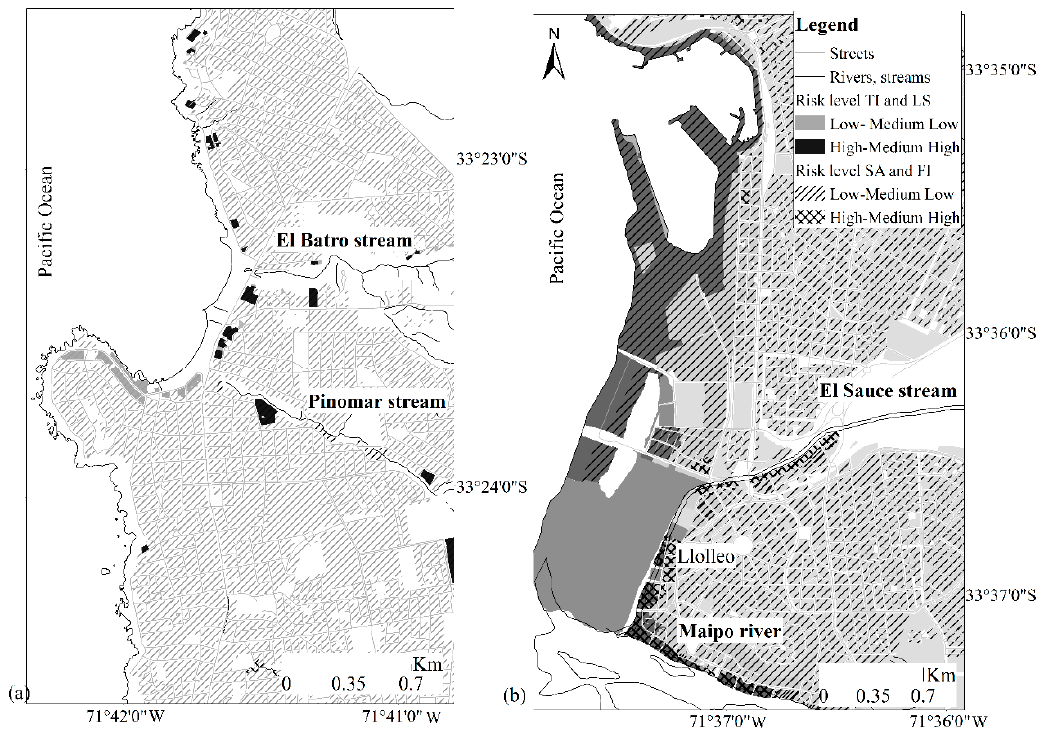
Figure 8. Housing integrated level of risk in ( a ) El Quisco and ( b ) San Antonio. The figures consider the Tsunami inundation (TI), landslide (LS), seismic amplification (SA), and fluvial inundation (FI) risk levels.